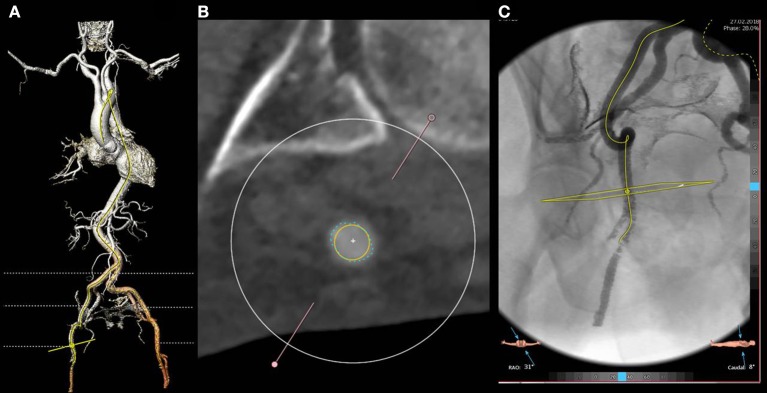
Three dimensional reconstruction of the arterial system (A) and cross section of the common right femoral artery at the optimal puncture site (B). The artery shows a good caliber (exceeding 6.5 mm as evident from the yellow circle) and no calcifications. Moderate tortuosity of the superficial iliac artery is evident at both 3 D and angio reconstruction (C). In particular, the angio reconstruction allows for the fluoro guided detection of the optimal access site, based on its relationship with the femoral head.